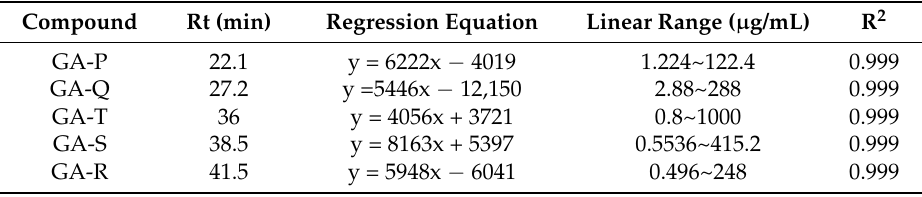
Figure 2. Representative RP-HPLC chromatogram of standard compounds (a) and methanol extracts of mycelia mat in nitrogen limitation groups on the 12th day of static culture (b–e, corresponding to L1, L2, M2 and H1 as indicated in Table 2, respectively). Table 1. Retention times, regression equations, linear ranges, and coefficients of the five